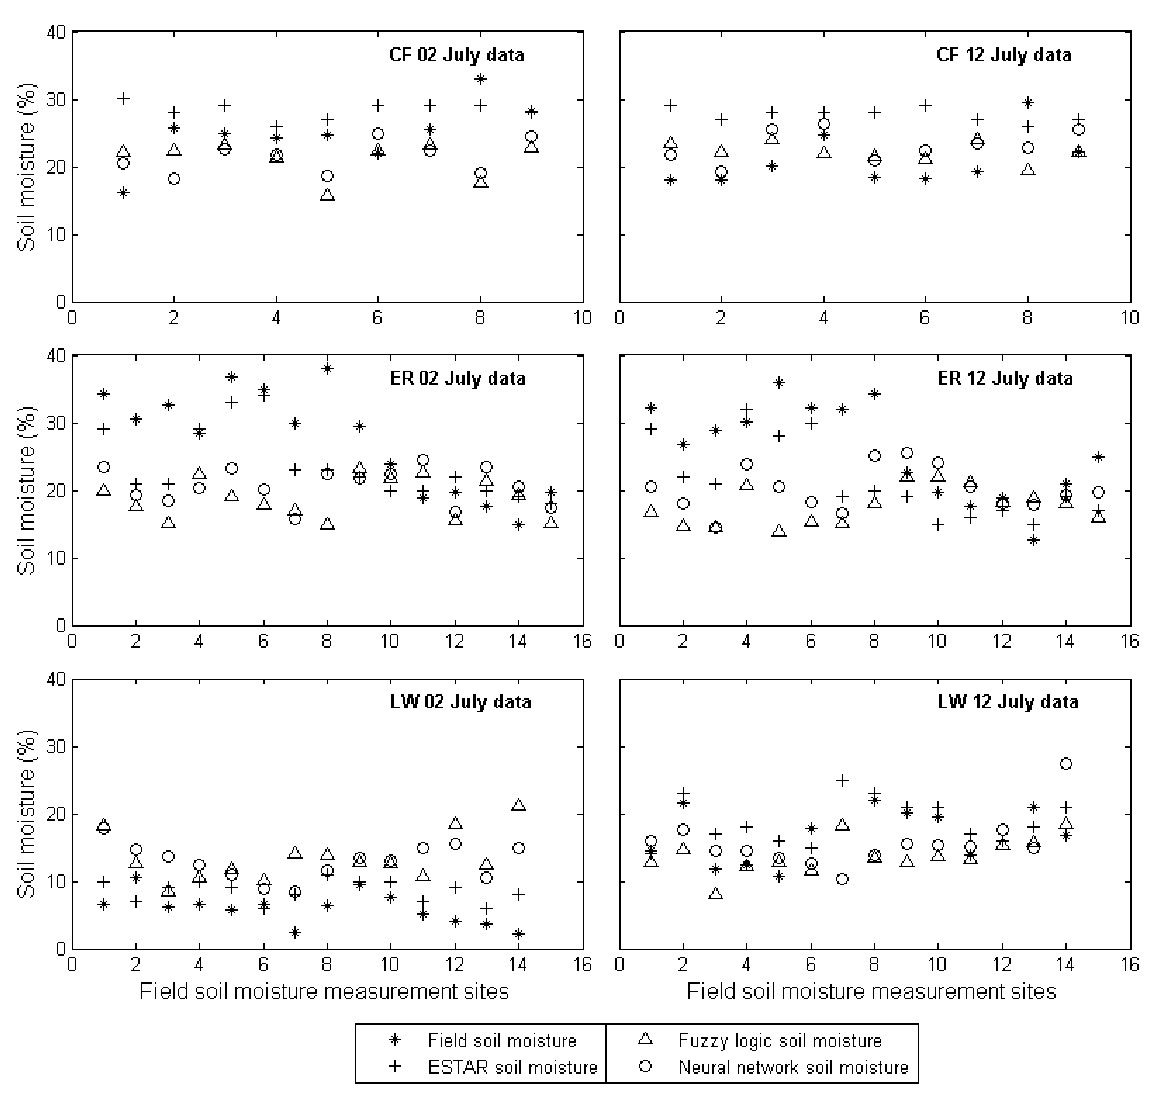
Figure 6. Comparison of predicted soil moisture from fuzzy logic model with field and ESTAR soil moisture with field soil moisture measuring area: Central Facility (CF), El Reno (ER), and Little Washita (LW) for July 02 nd (a), July 12 th (b)